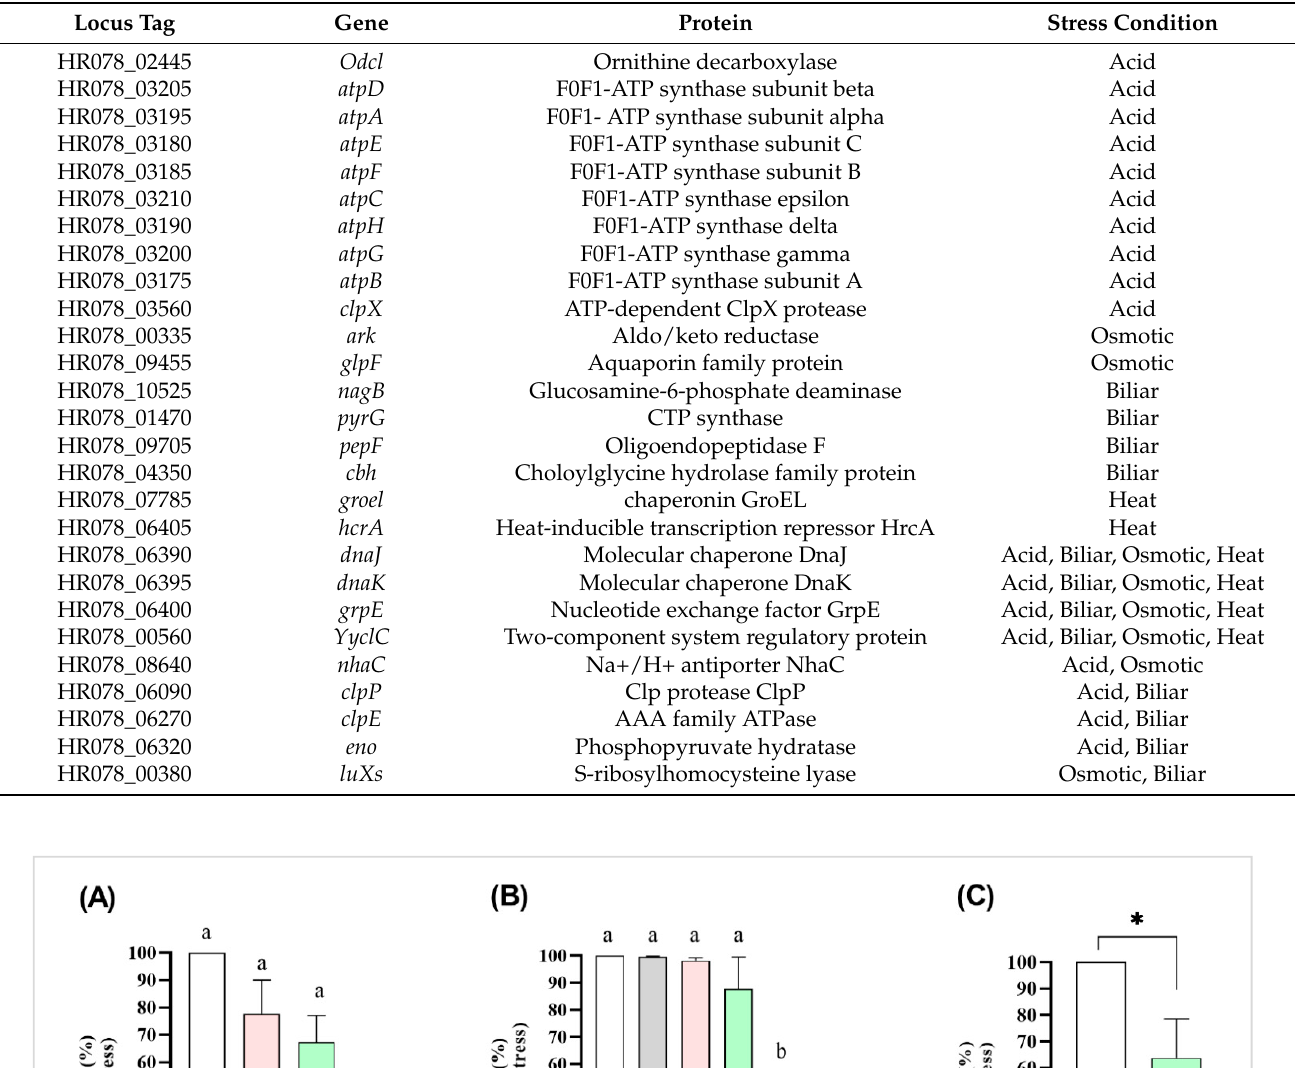
Table 3. Gene’s prediction involved with stress tolerance of Lactobacillus delbrueckii CIDCA 133. Locus Tag